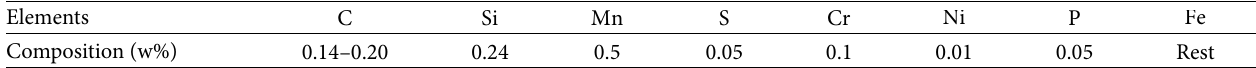
Table 1: Chemical composition of mild